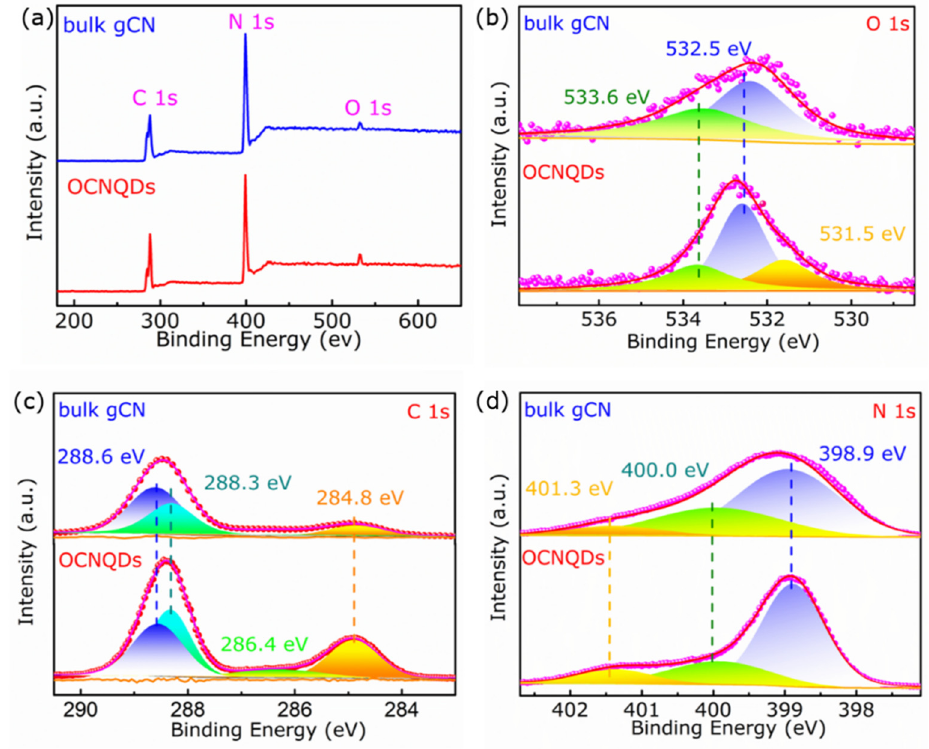
Figure 4. ( a ) The survey XPS spectra; ( b – d ) narrow scan spectra of O 1s, C 1s, and N 1s of OCNQDs and bulk gCN. Table 1. Elemental analysis (C, N, O atomic %) of the OCNQDs and bulk gCN performed by XPS.